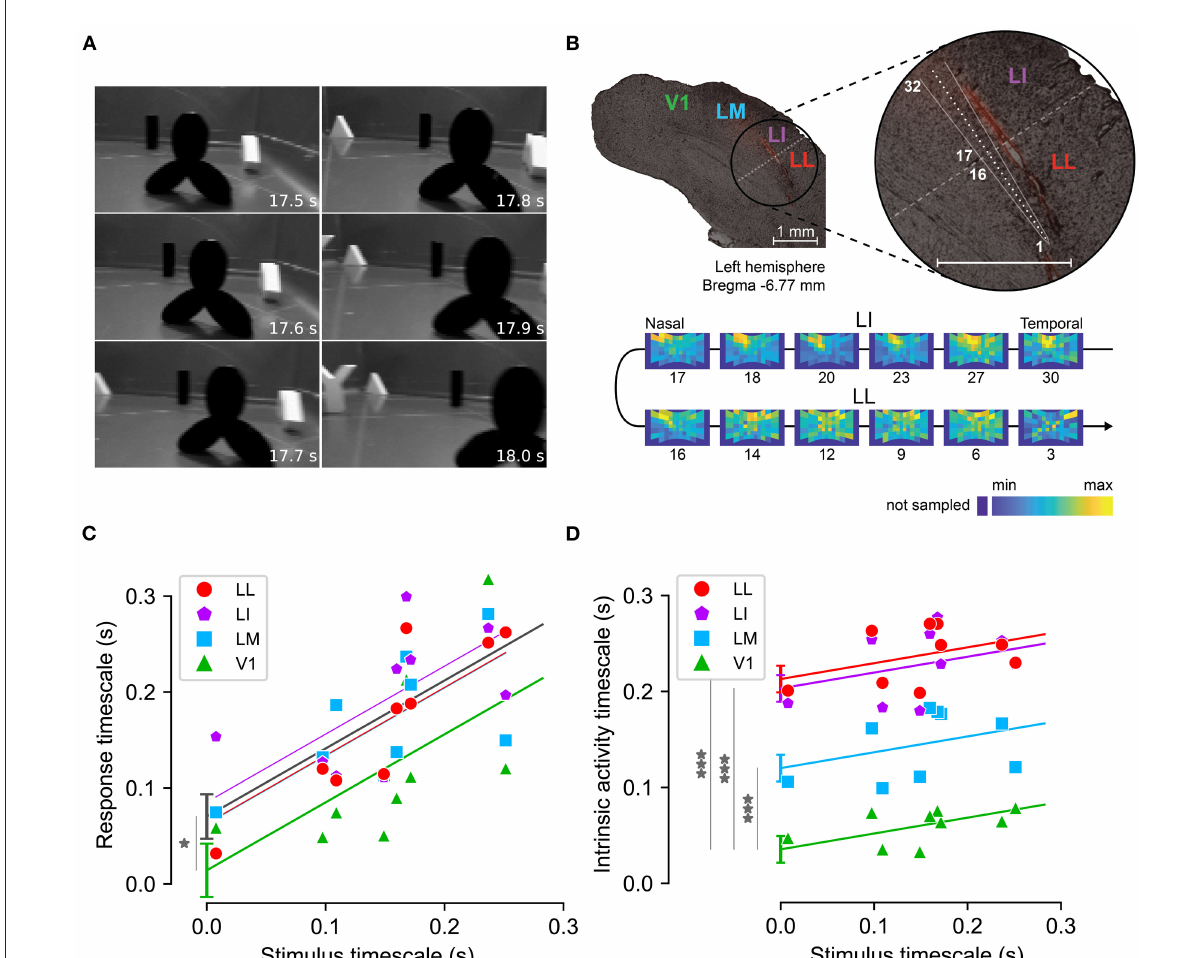
FIGURE6 Measuring response and intrinsic timescales along the rat analog of the ventral visual stream. (A) Example frames from one of the nine movies used as visual stimuli. (B) Functional identification of rat cortical areas. Top: example slice of rat visual cortex, obtained from one of the rats where recordings were performed. Red fluorescence indicates the insertion path of the multielectrode silicon probe, schematized in white. Bottom: firing intensity maps showing the RFs of the units recorded at selected recording sites along the probe (indicated by the numbers under the RF maps). The reversal in the progression of the retinotopy between sites 16 and 17 marks the boundary between areas LI and LL (shown by a dashed line on the top panel). (C) Response timescales (y-axis) measured across the cortical hierarchy for stimuli with different timescales (x-axis). Markers indicate empirical estimates, lines indicate linear regression with common slope across areas and varying intercept. Gray line indicates a regression where all extrastriate areas (LM, LI, LL) are pooled together and compared to V1. (D) Same as (C) , for intrinsic timescales. Adapted from Piasini et al.